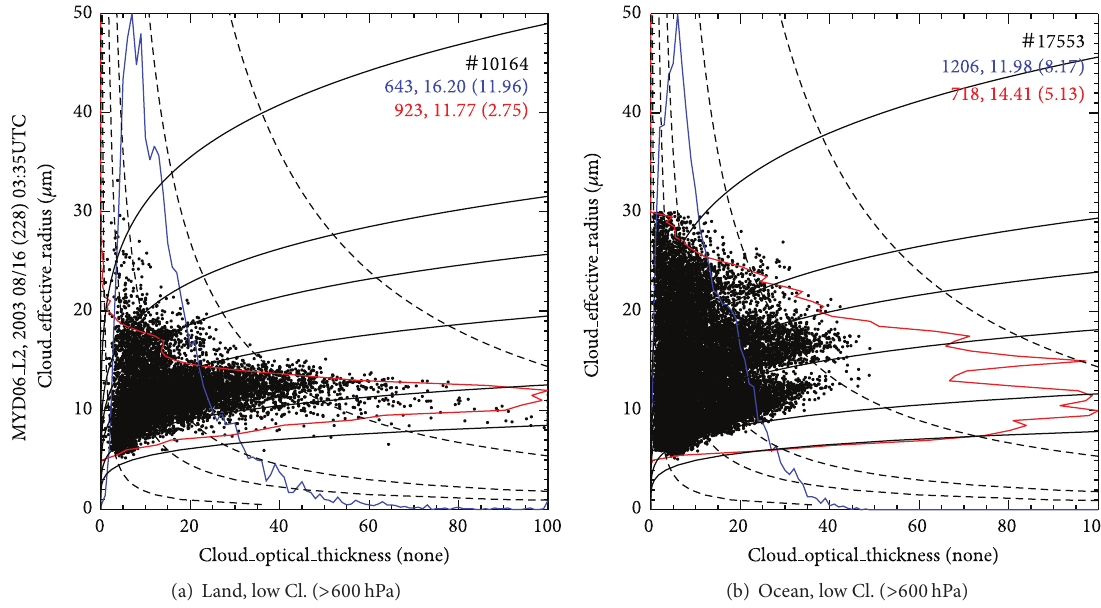
Figure 16: Same as Figure 15 but at 0335 UTC August